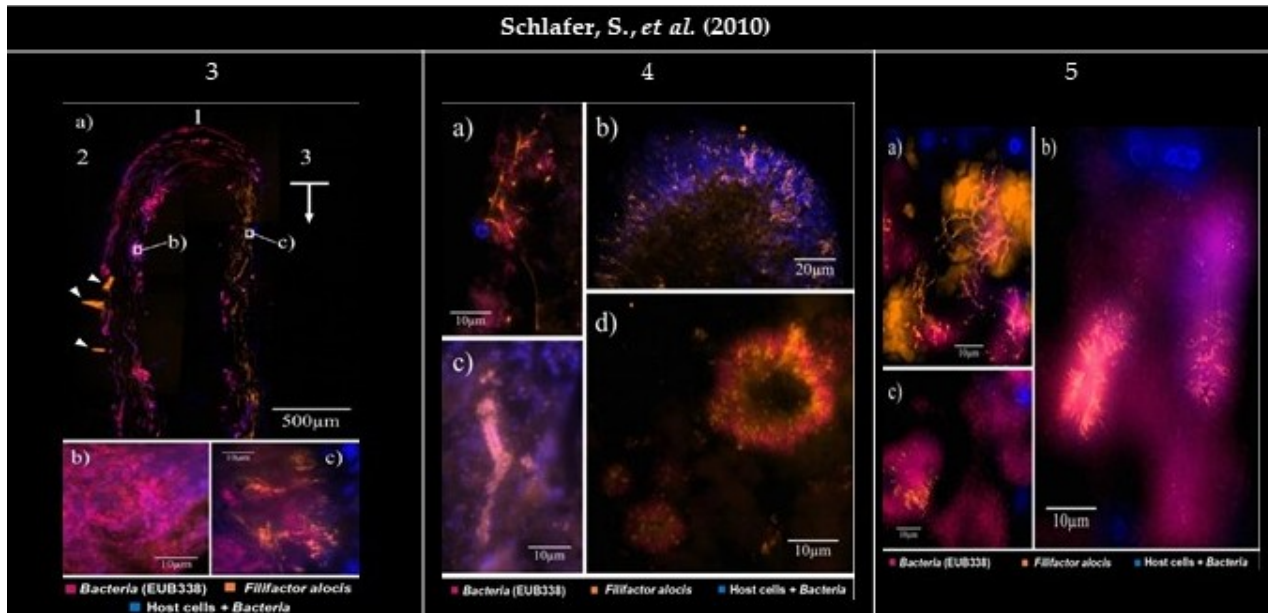
Figure 3. Panel of the gathered images. ( 3 ) Subgingival biofilm visualized by FISH (Fluorescence in situ hybridization). EUB338 Cy5 (Cyanine 5) (magenta), FIAL Cy3 (Cyanine 3) (bright orange), and DAPI (4′, 6-diamino-2-phenylindole) staining (blue). DAPI stains both host cell nuclei and bacteria. ( 3a1 ) The carrier tip. ( 3a2 ) The carrier side facing the tooth. ( 3a3 ) The carrier side facing the pocket epithelium. ( 3a1 , 2 ) Little or no presence of Filifactor alocis . ( 3a3 ) Presence of a bright orange signal, indicating a vindicated presence of F. alocis (arrow). The image show artifacts caused by the folding of the embedded carriers (arrowheads). ( 3b , c ) Higher magnification. ( 3b ) Rare colonization of F. alocis amongst the bacteria. ( 3c ) F. alocis in densely packed groups among the organisms on the carrier side facing the soft tissues and host cell nuclei (blue). ( 4 ) Establishment of Filifactor alocis in a subgingival biofilm. ( 4a ) Overlay of FIAL Cy3 , EUB338 Cy5 , and DAPI filter sets. In some parts of the biofilm F. alocis rods can reach a considerable length. ( 4b , c ) Overlay of FIAL Cy3 and DAPI filter sets. ( 4b ) Radial orientation of F. alocis towards the exterior of a mushroom-like protuberance. ( 4c ) Test-tube-brush formations of F. alocis around signal-free channels. ( 4d ) Overlay of FIAL Cy3 and EUB338 Cy5 filter sets. F. alocis and fusiform bacteria form concentrical structures. ( 5 ) Establishment of Filifactor alocis in periodontal tissue. ( 5a ) F. alocis forming tree-like structures among coccoid and fusiform bacteria and autofluorescent erythrocytes. ( 5b ) F. alocis forming palisades with fusiform bacteria around large rod-shaped eubacterial organisms. ( 5c ) F. alocis being part of concentrical bacterial aggregations such as those found in ( 4d ). All images were reprinted and adapted with the publisher’s permission.